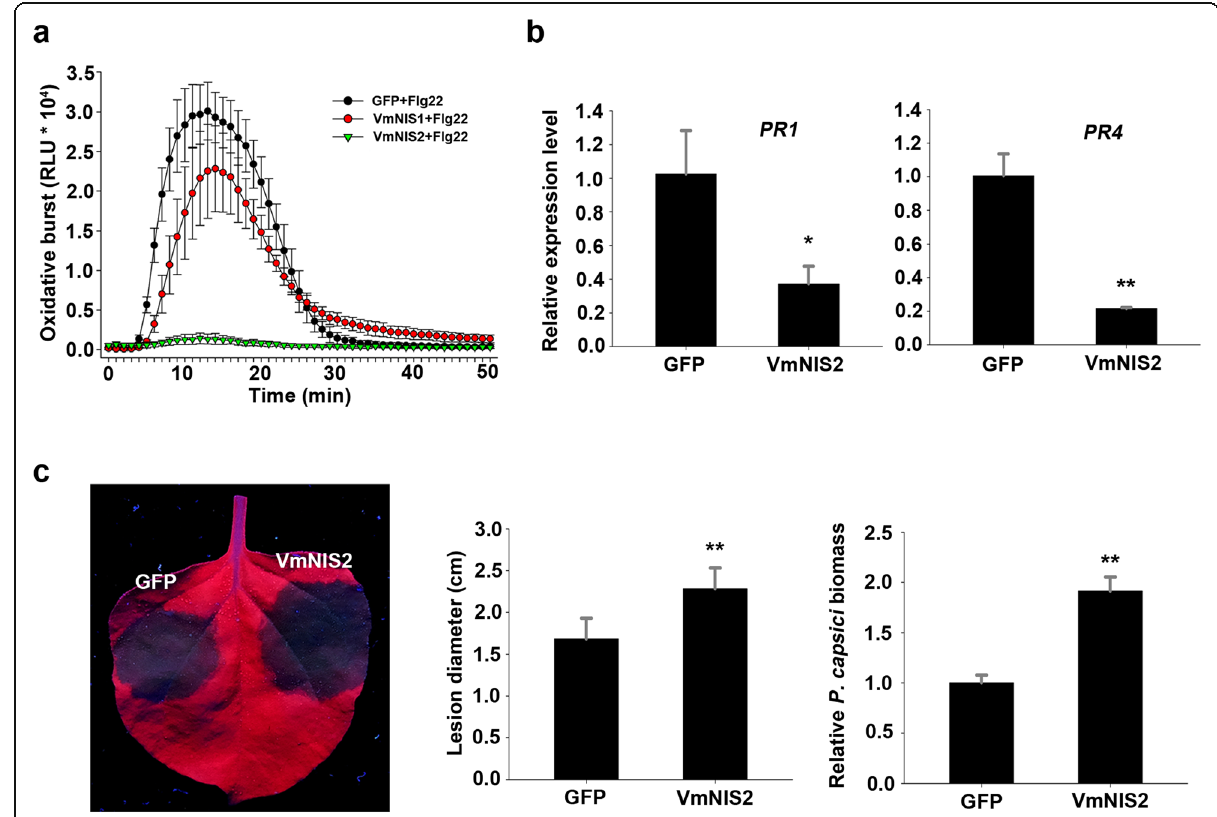
Fig. 4 VmNIS2 suppresses immune responses in N. benthamiana . a. Influence of flg22-elicited oxidative burst by VmNIS1 and VmNIS2 in N. benthamiana . VmNIS1, VmNIS2 or GFP control were transiently expressed in N. benthamiana leaves. ROS production represented by RLU was measured by treatment with 1 μ M flg22 peptide. b. Transcript accumulation of PR1 and PR4 in N. benthamiana transiently expressing VmNIS2 or GFP control. Transcript levels of the two genes were determined by RT-qPCR, with NbActin serving as the internal reference. Values represent the means ± SD of three biological replicates. Differences were assessed by Student ’ s t -test. *, P < 0.05; **, P < 0.01. c. Transient expression of VmNIS2 promoted P. capsici infection on N. benthamiana . The leaves were agroinfiltrated with VmNIS2 or GFP control 2 d before inoculation. Representative leaves showing P. capsici -caused lesions were taken 36 h post inoculation under a UV light. Lesion diameters were calculated from six biological replicates, and relative P. capsici biomass was determined by RT-qPCR. Values represent the means ± SD. Differences were assessed by Student ’ s t -test. **, P <